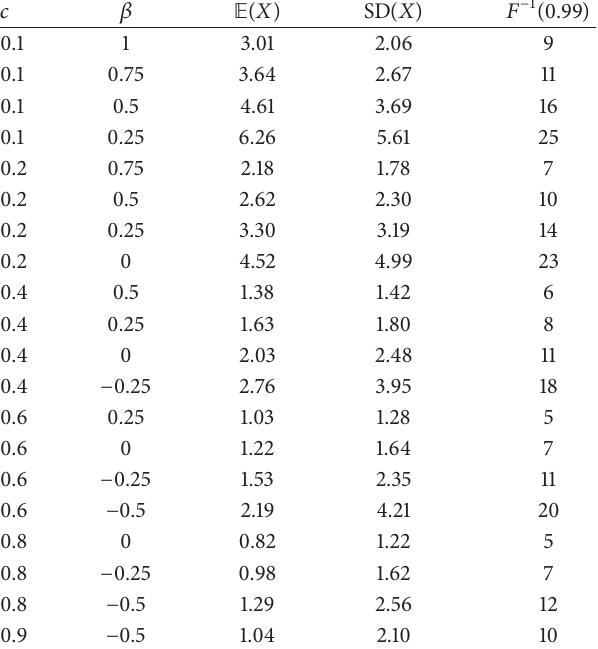
Table 1: Parameter combinations and corresponding expected value, standard deviation, and 0.99 -quantile for the simulation